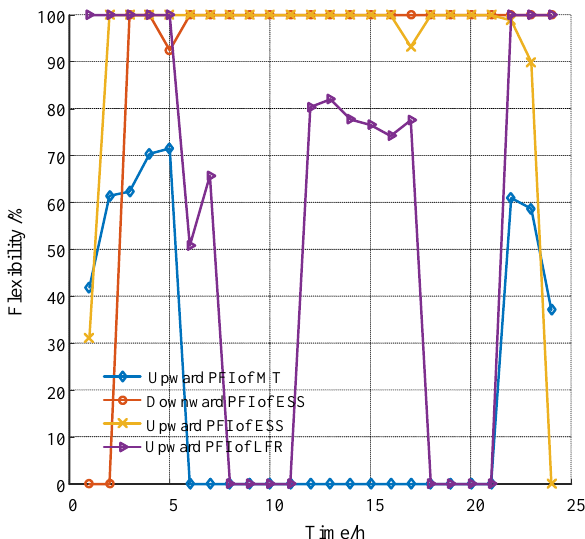
Figure 10. PIES flexibility index of each equipment.